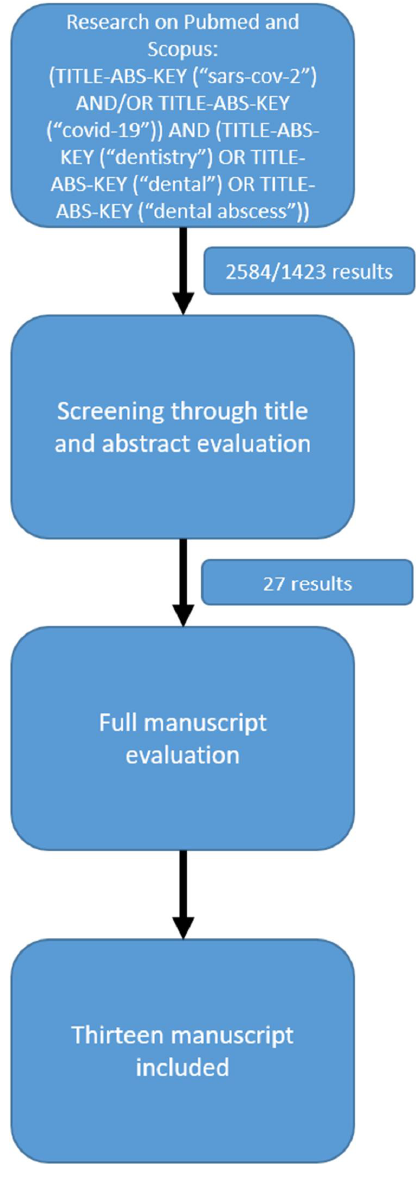
Figure 1. Articles screening process. Table 1. Included articles (in alphabetical